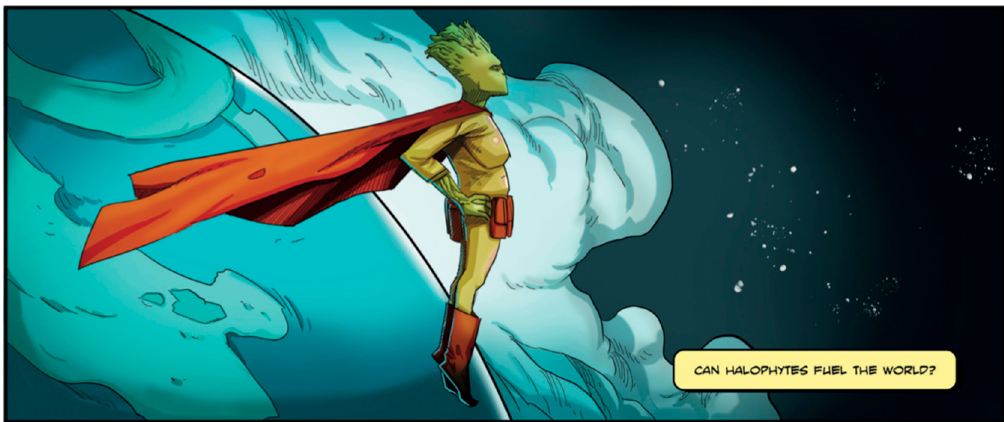
Figure 2. The “superhero” trope inherent in the concept “Can halophytes fuel the world?”.